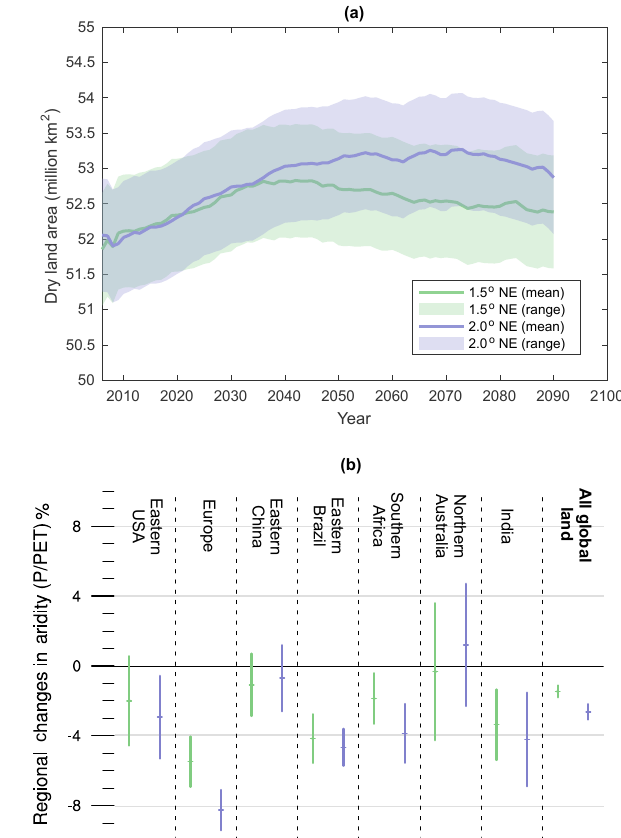
Figure 8. (a) Solid lines show the ensemble mean of aggregated land which qualifies as “dry” land, where aridity ( P / PET) < 0.65. Lines are smoothed to show the 20-year running average value. Shaded areas are calculated as ± 1 annual SD from the mean in the respective ensemble. Panel (b) shows the change in aridity for a number of specific regions in 2071–2100 relative to 1976–2005. Central dashes indicate the ensemble mean value, while the vertical lines indicate the full spread in the 1.5degNE and 2.0degNE ensem- bles.